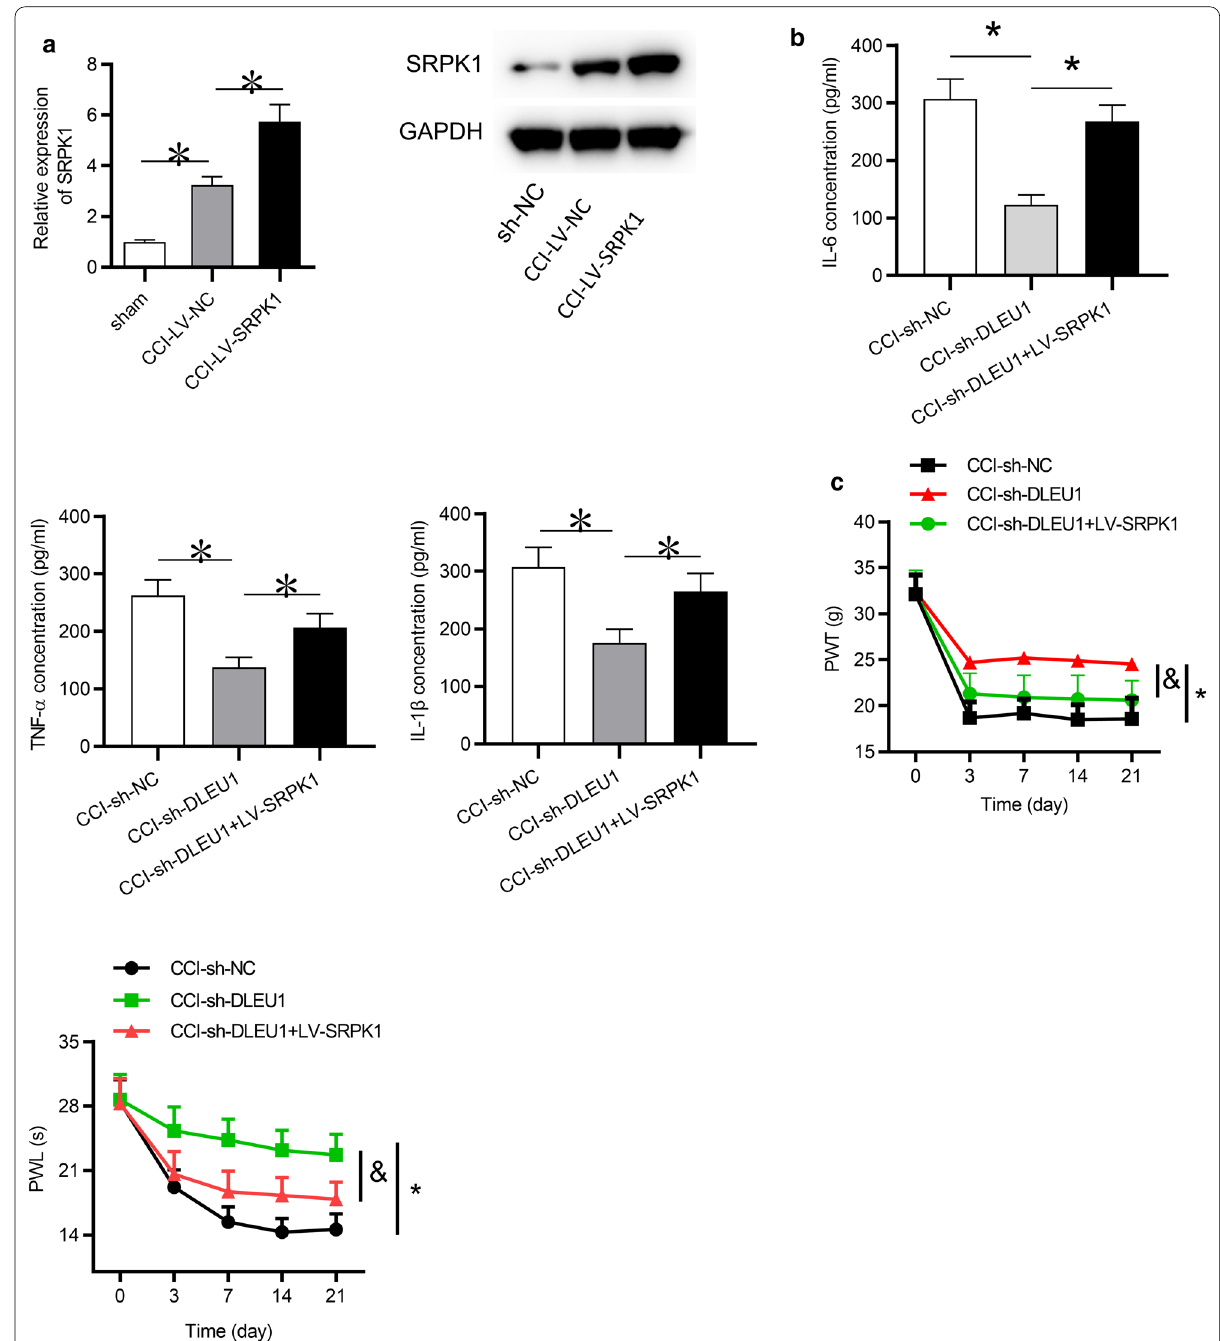
Fig. 5 Overexpression of SRPK1 reversed the effects of silenced DLEU1 on inflammation and neuropathic pain-like behaviors in CCI rats. a The mRNA or protein expression of SRPK1 in CCI rats spinal cord tissues infected with lentivirus encoding SRPK1 at postoperative day 7 was detected by RT-qPCR analysis. N 8 for each group. b ELISA tested the concentrations of IL ‐ 6, TNF-α and IL ‐ 1β in spinal cord tissues of CCI rats at postoperative = day 7. N 8 for each group. c Paw withdrawal mechanical threshold (PWT) at postoperative days 0, 7, 14 and 21 days. N = thermal hypersensitivity was assessed by paw withdrawal latency (PWL) at postoperative days 0, 7, 14 and 21 days. N & p <